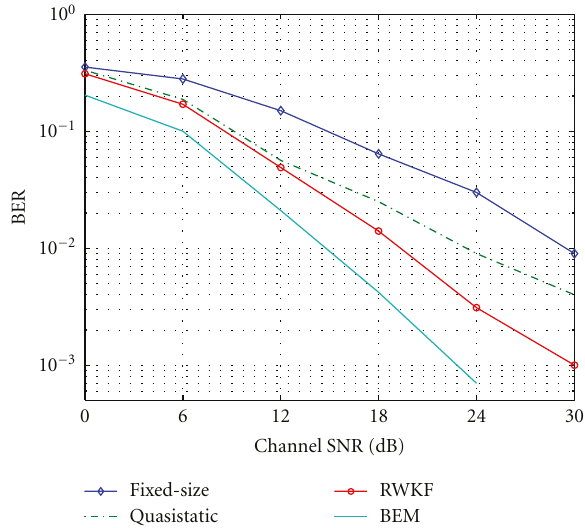
Figure 3: BER comparisons for various channel tracking schemes.